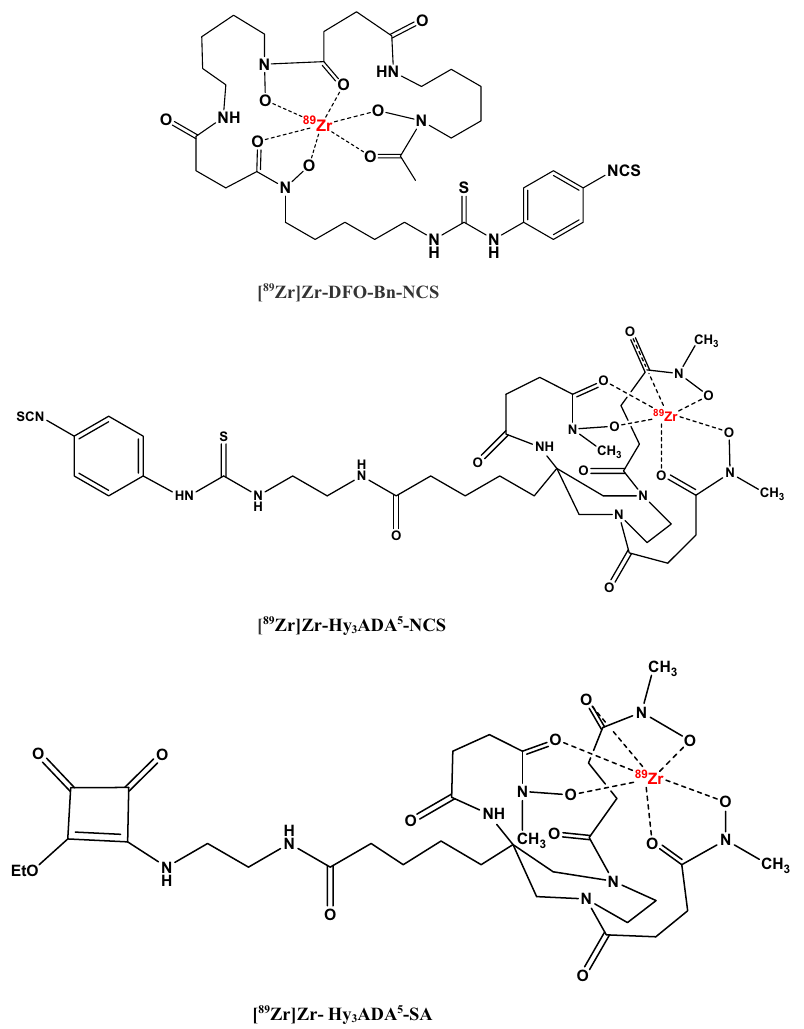
Figure 1. Chemical structures of [ 89 Zr]Zr-DFO-Bn-NCS, [ 89 Zr]Zr-Hy 3 ADA 5 -NCS and [ 89 Zr]Zr- Hy 3 ADA 5 -SA.